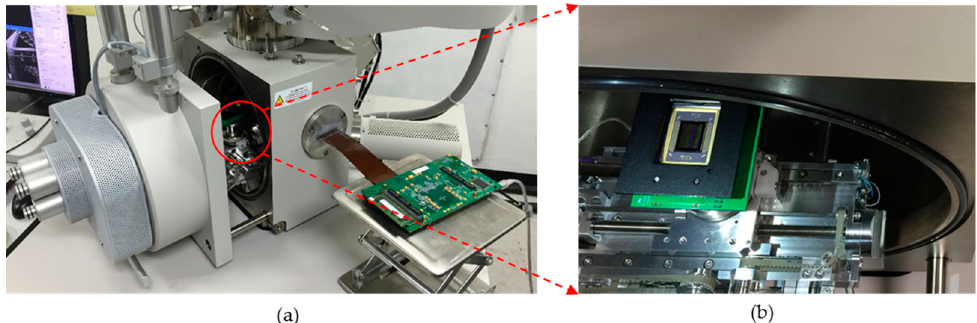
Figure 3. In situ SEM testing set-up: the digital light procession (DLP) circuit board in ( a ) is connected with the ( b ) DMD chip inside the SEM chamber through a data cable. The compact size of the DMD chip unit can ensure the remote operation via the data cable inside the SEM.